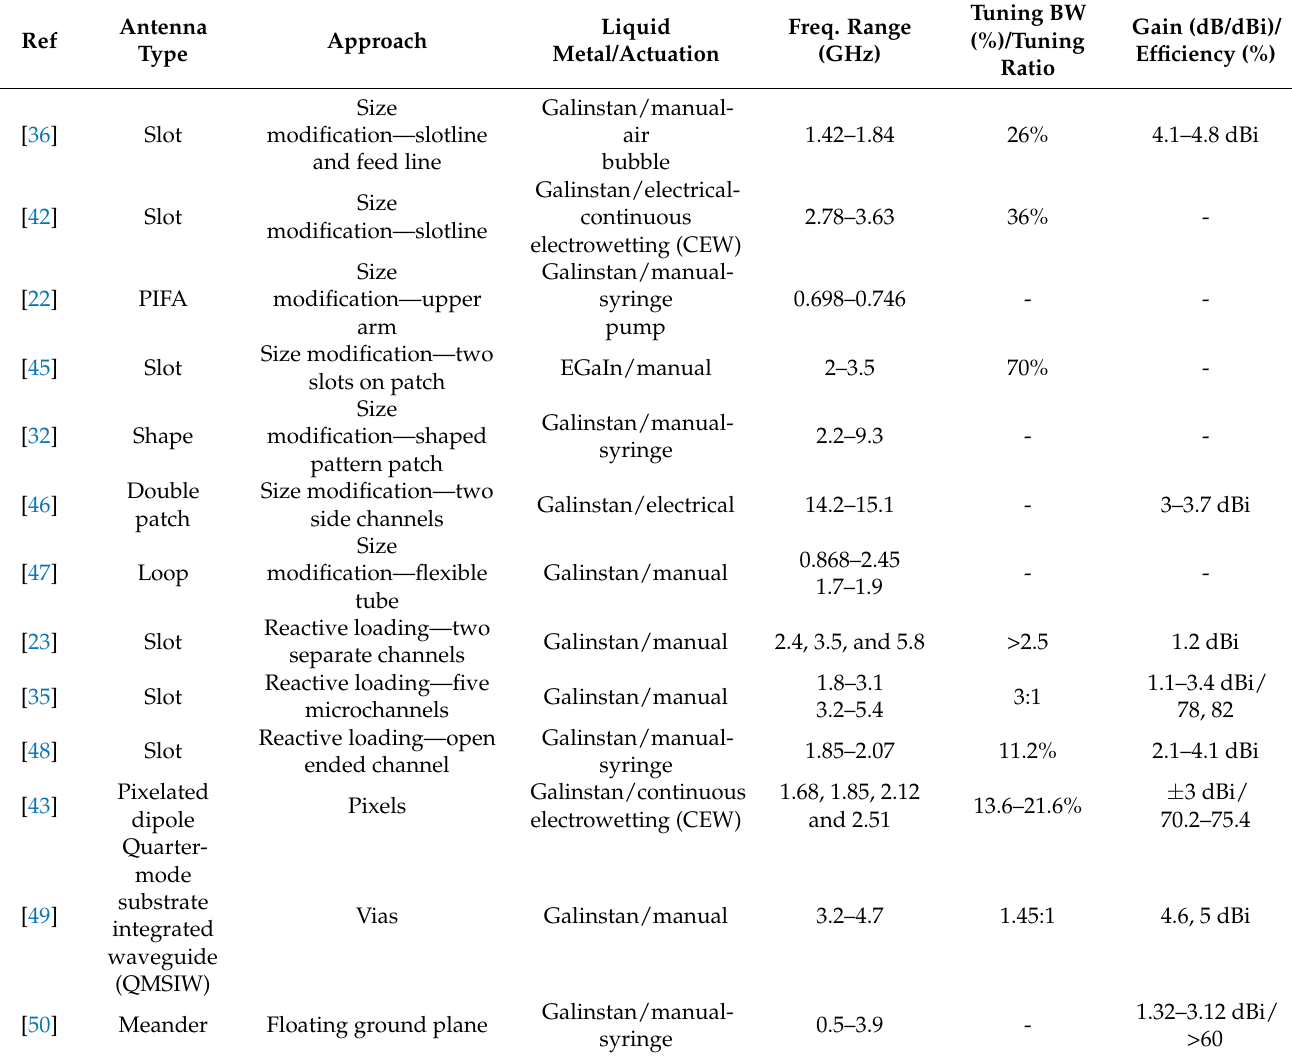
Table 2. Summary of frequency reconfigurable antennas using nontoxic conductive